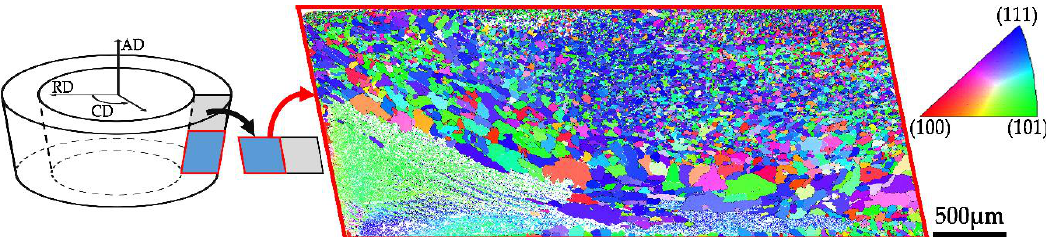
Figure 9. Orientation maps obtained by Electron Backscattered Diffraction (EBSD) after 1/8 rotation (45°) t -HPS (half cone angel 10°) across the lower half of vertical section of the 5N aluminum sample (AD: the axial direction, CD: the circumferential direction, RD: the radial direction).